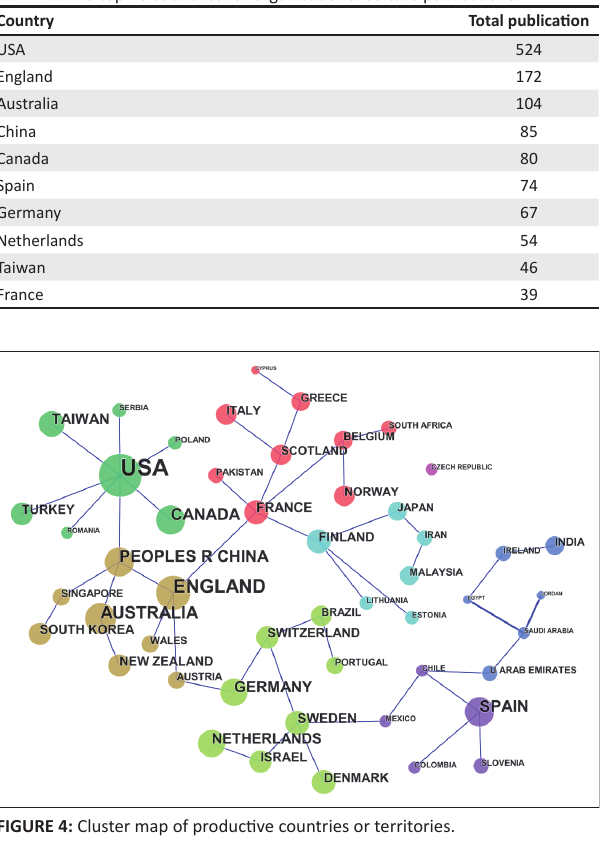
TABLE 4: The top 10 countries for organisational culture publications.